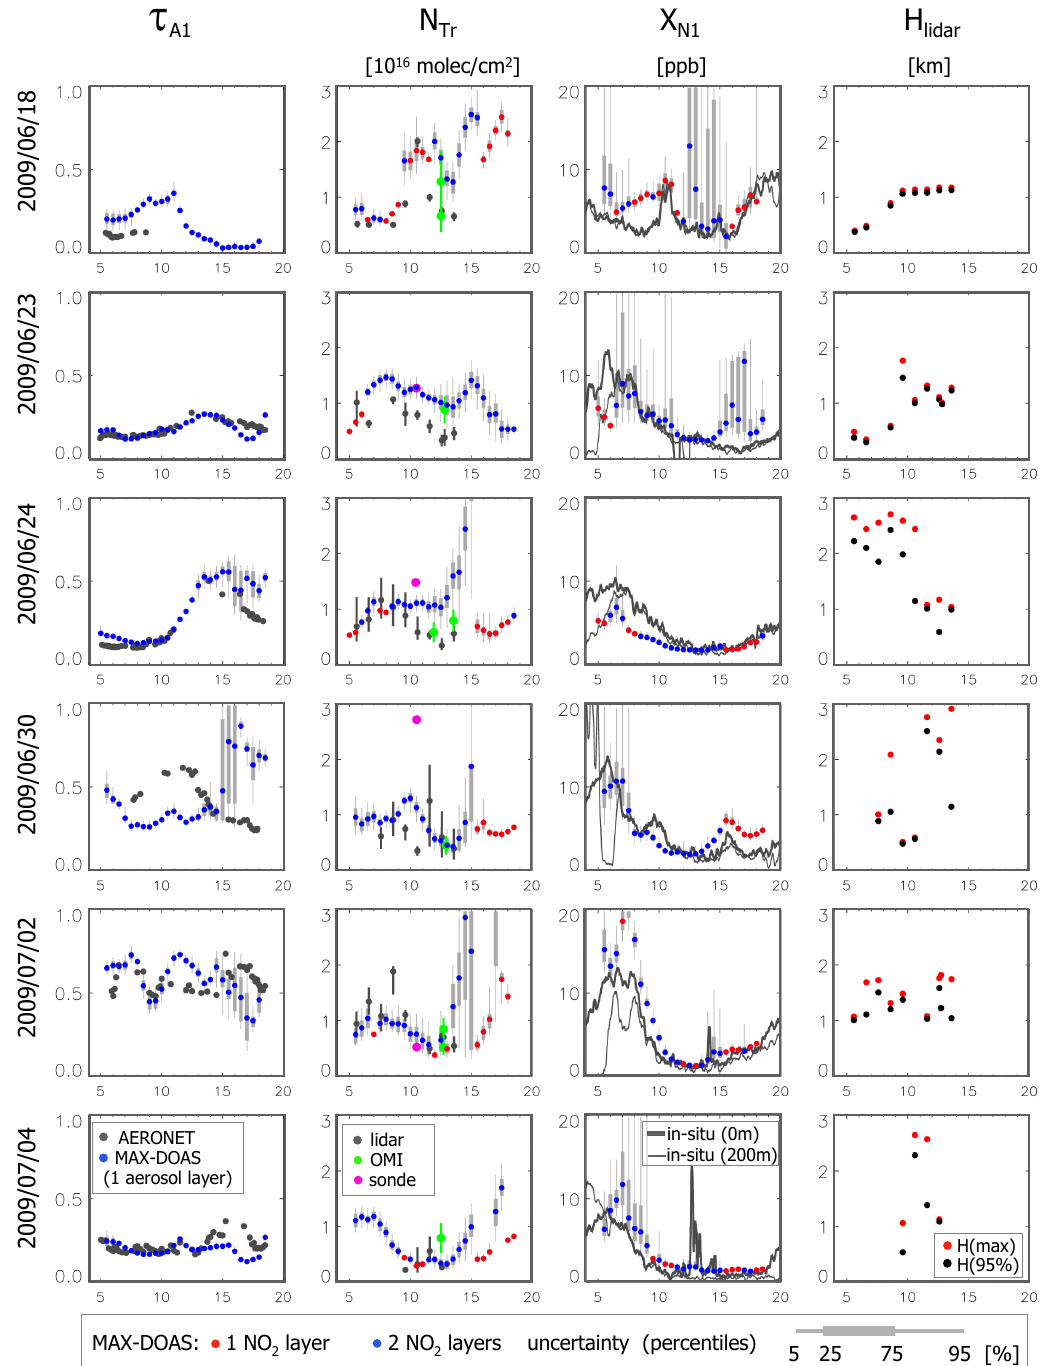
Fig. 11. Results of retrieval algorithm applied to MAX-DOAS observations on six selected days during the CINDI campaign, and comparison with independent observations: aerosol optical thickness from AERONET (first column), tropospheric NO 2 columns from lidar, OMI and sonde (second column), and NO 2 volume mixing ratios from in-situ monitors located at two different altitudes in the Cabauw tower (third column). MAX-DOAS retrievals based on the one NO 2 layer model are indicated with a light gray error bar, whereas dark gray indicates the use of the two NO 2 layer model. The selection of the retrieval model is based on the lowest value of χ 2 column shows the height up to which the lidar profile was reported, and the height below which altitude 95% of the lidar NO 2 column was found. For OMI only the pixel with its center closest to Cabauw was selected. On two occasions Cabauw was exactly between two pixel centers, and both were